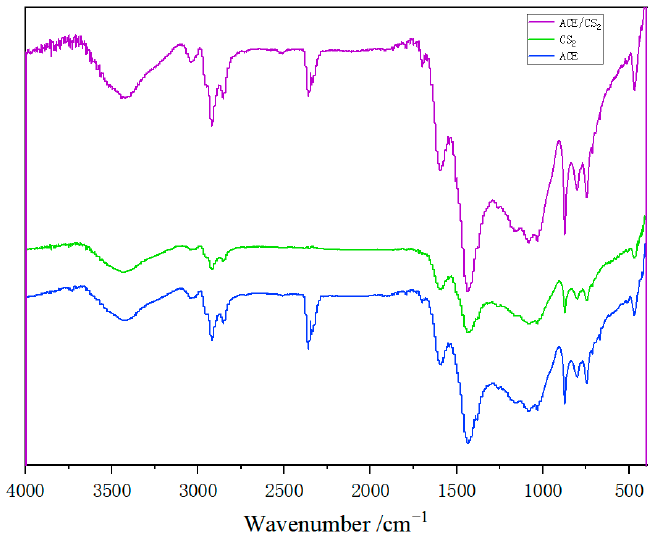
Figure 1. Infrared spectra of three solvent extracts from coal tar residues.